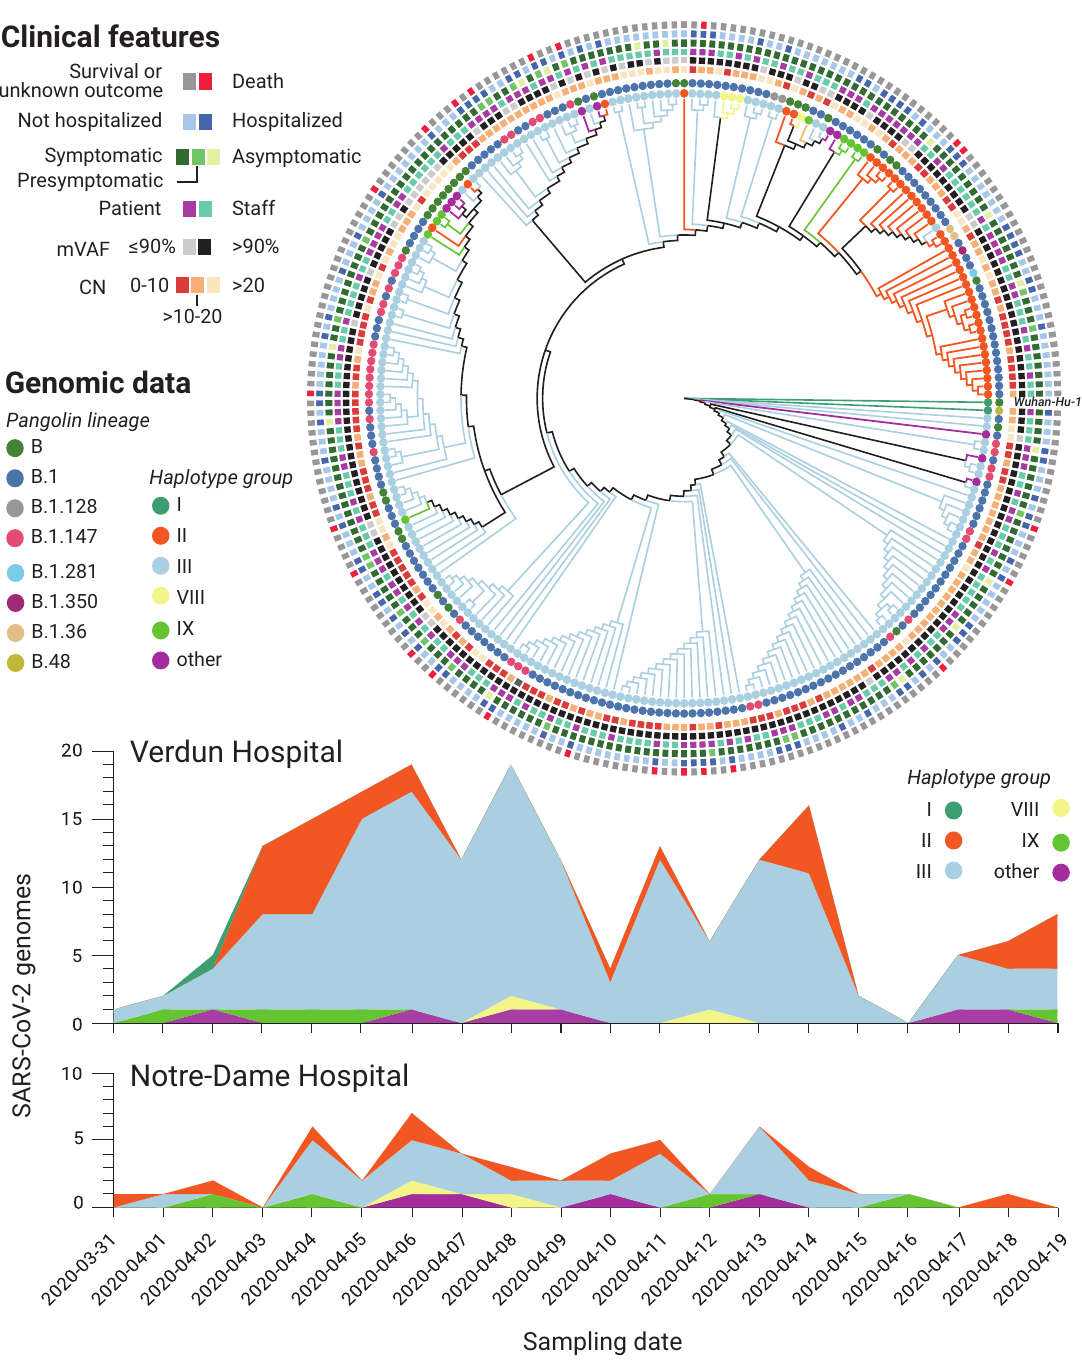
Fig 3. Genomic and clinical features of 234 SARS-CoV-2 infections. (Top) Maximum likelihood phylogenetic tree reconstruction of de novo assembled genomes spanning at least 80% of the SARS-CoV-2 reference genome (Wuhan-Hu-1) covered by � 20 reads and annotated with clinical features of interest. The phylogeny was calculated from a multiple sequence alignment generated with MAFFT [19] using MEGA [20] and visualised with Iroki [21]. Lineage classification performed with Pangolin 2.1.10 [12] (outer circles) and haplotype assignment was performed based on the 20 most common variants in GISAID [18] from the first wave of the pandemic (inner circles). (Bottom) Haplotype diversity over time across two local hospitals. mVAF: Median variant allele frequency, CN: Cycle